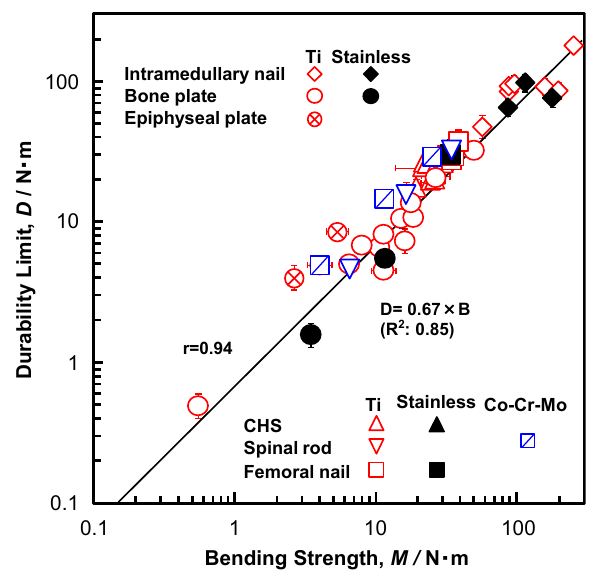
Figure 8. Relationship between durability limit and bending strength of osteosynthesis devices, as determined by four-point bending tests and compression bending tests.